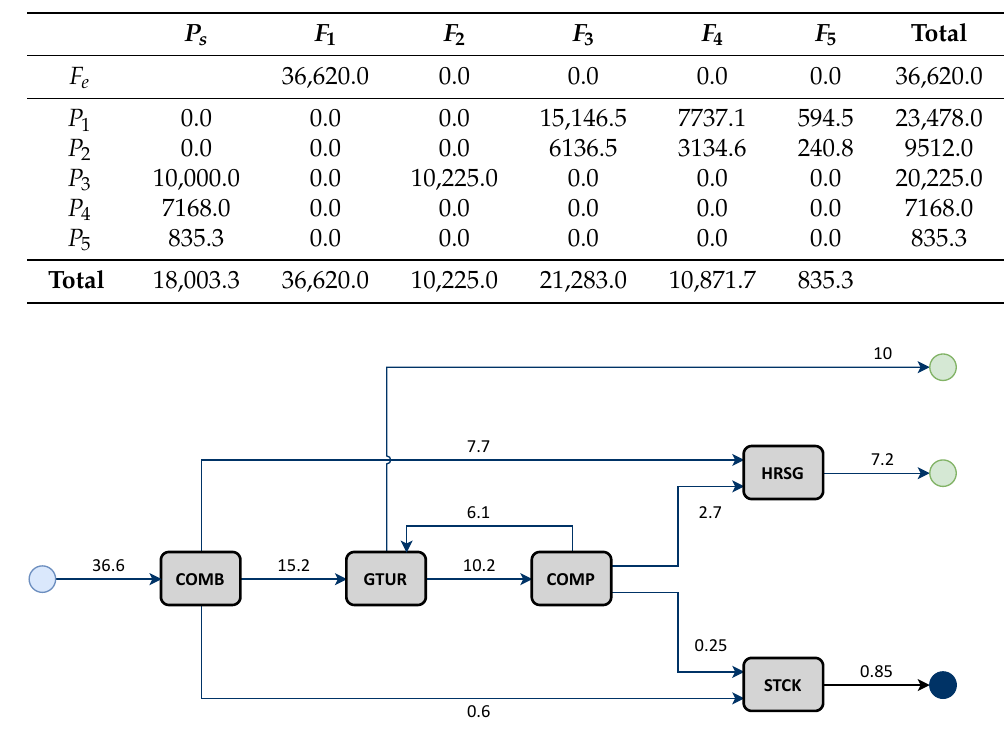
Table 7. Fuel product table of TGAS plant (kW).